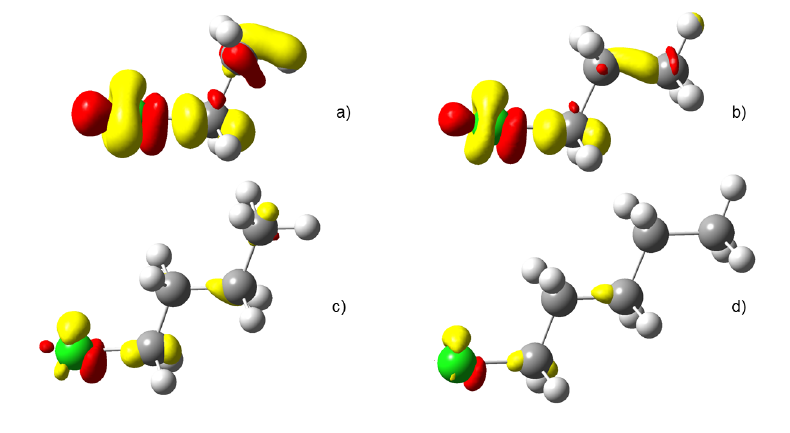
Figure 4. polarisation electron density of alkyl chlorides from ( a – d ), two to five carbons. δρ > 0 colored in red while δρ < 0 colored in yellow. Isovalue of 5.0 × 10 − 5 a . u .